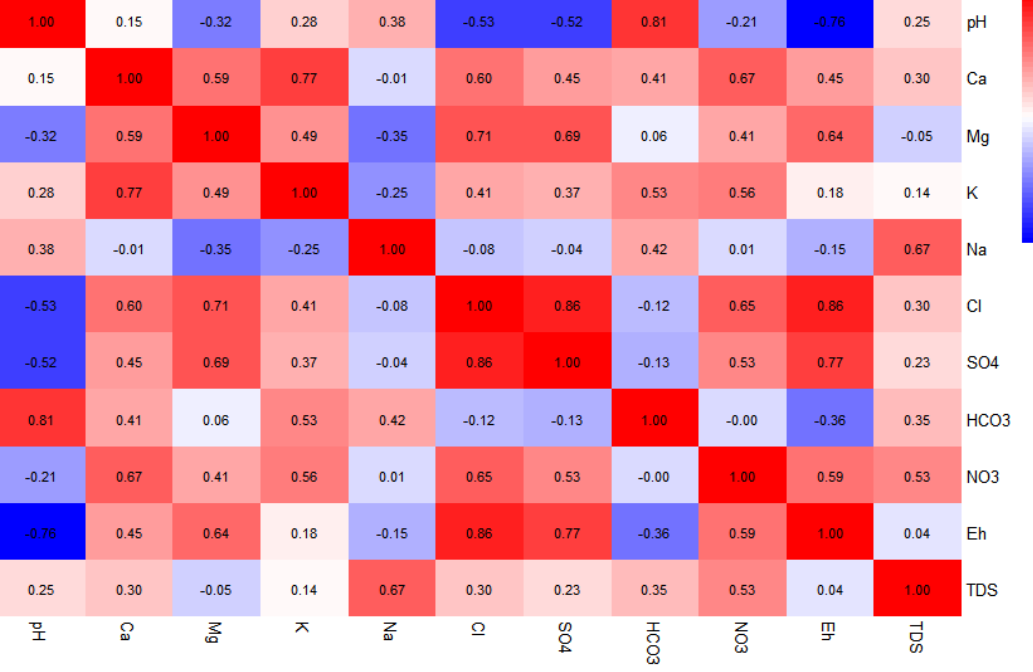
Figure 5. Correlation between major hydrochemical parameters of groundwater.